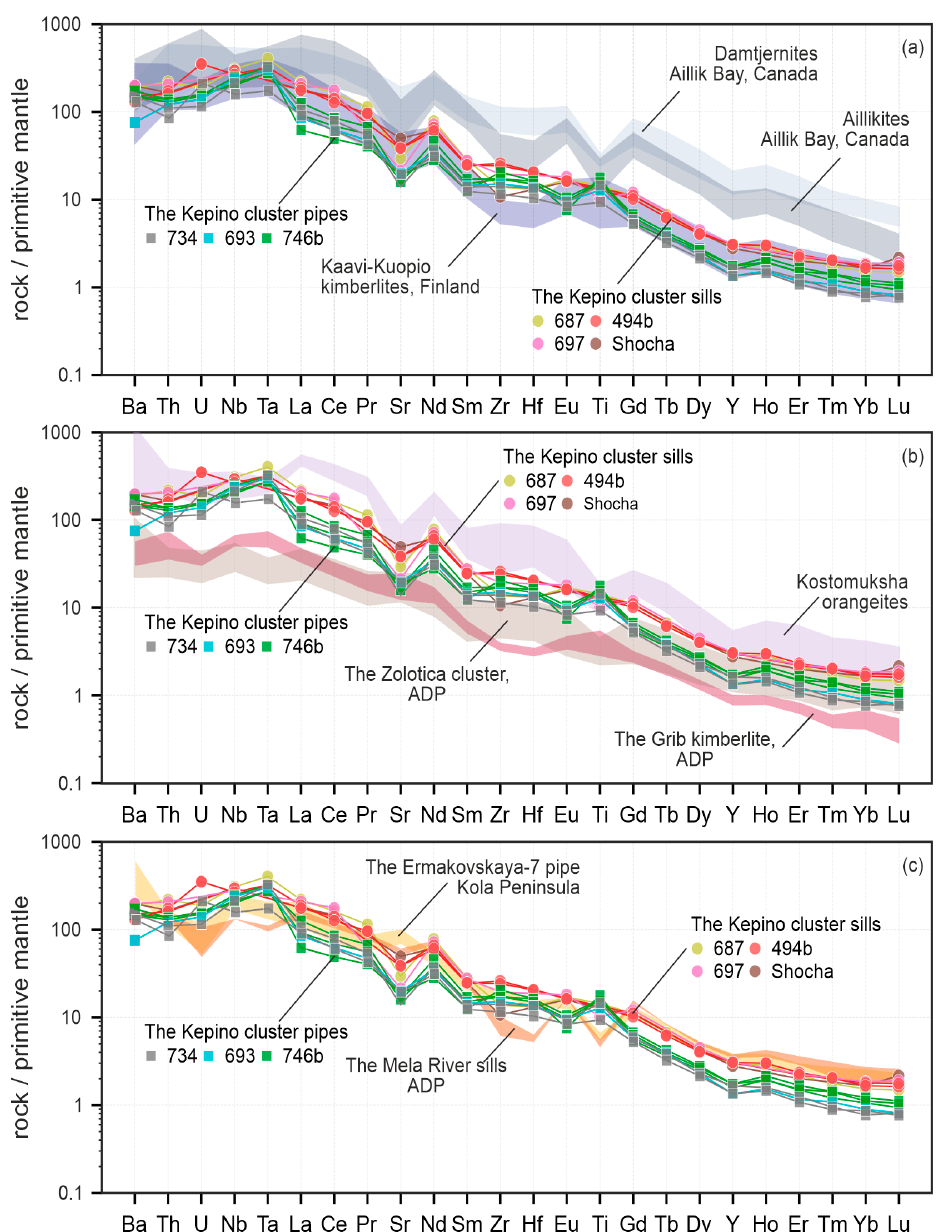
Figure 12. Trace elements normalised to primitive mantle [68] for kimberlites from the Kepino sills and pipes: ( a ) in comparison with aillikites and damtjernites from Aillik Bay, Canada, based on [59] and kimberlites from Kaavi-Kuopio, Finland, based on [67]; ( b ) in comparison with diamondiferous kimberlites of the Grib pipe and Zolotica cluster, ADP, and with orangeites of Kostomuksha area, Karelia, Russia [60]; ( c ) in comparison with carbonate-bearing kimberlite of the Mela River sills, ADP, and evolved kimberlites from the Ermakovskaya-7 pipe, Tersky coast, Kola Peninsula, Russia. The second group consists of kimberlite samples from sills 494b, 687, 697, and Shocha and is characterised by enrichment in all REEs relative to kimberlites from pipes and slightly negative anomalies of Ti and Zr–Hf relative to REE or a lack of them. A comparison of studied kimberlites of the Kepino cluster with ultramafic alkaline lamprophyres [59] shows that the studied rocks have a lower amount of trace elements and differ by strong negative anomalies of Zr–Hf and Ti related to REE (Figure 11a). From diamondiferous kimberlites of the Grib pipe and Zolotica cluster, the studied kimberlites differ by a higher level of REE concentrations, a negative Sr anomaly, and a wider variation of Zr–Hf and Ti concentrations (Figure 11b). By the level of REE